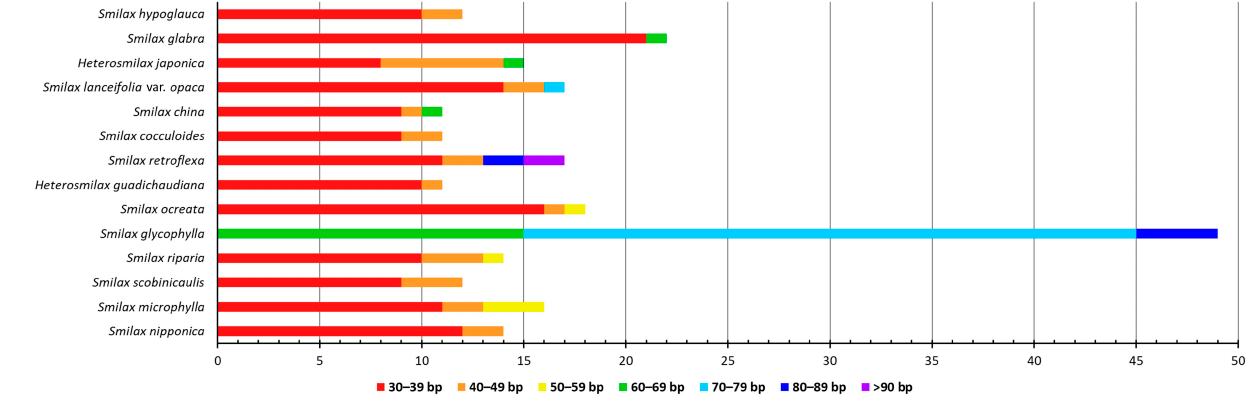
Figure 4. Length interval (bp) of LTRs detected from fourteen Smilacaceae species.